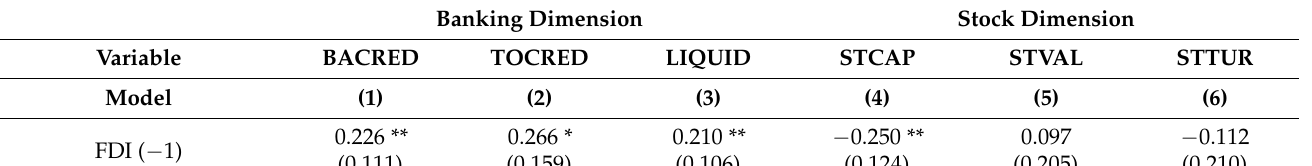
Table 7. The regression results of the impact of financial development on FDI during non-crisis